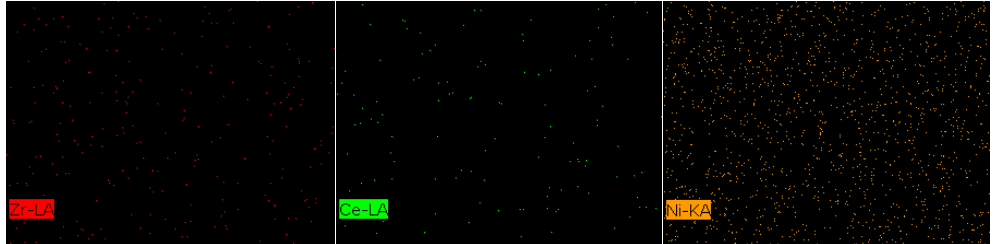
Figure 6. The distribution map of each element and EDS spectrum of the composite coating at the current density of 40 A / dm 2 .